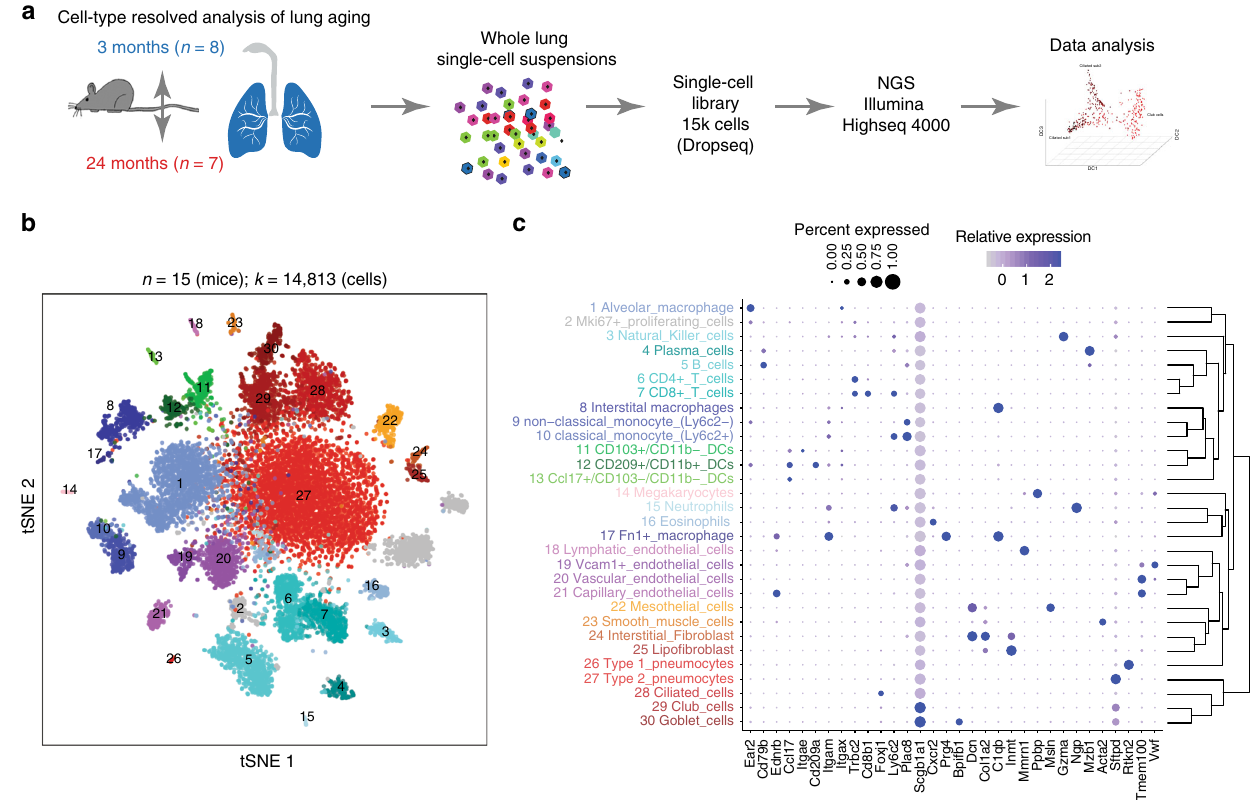
Fig. 1 A single-cell atlas of mouse lung reveals major cell-type identities. a Experimental design — whole lung single-cell suspensions of young and old mice were analyzed using the Dropseq work fl ow. b The t -distributed stochastic neighbor embedding (tSNE) visualization shows unsupervised transcriptome clustering, revealing 30 distinct cellular identities. c The dotplot shows (1) the percentage of cells expressing the respective selected marker gene using dot size and (2) the average expression level of that gene based on unique molecular identi fi er (UMI) counts. Rows represent hierarchically clustered cell types, demonstrating similarities of transcriptional pro fi